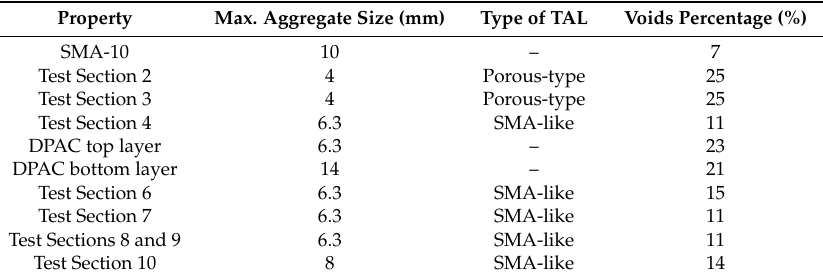
Table 1. Mixture